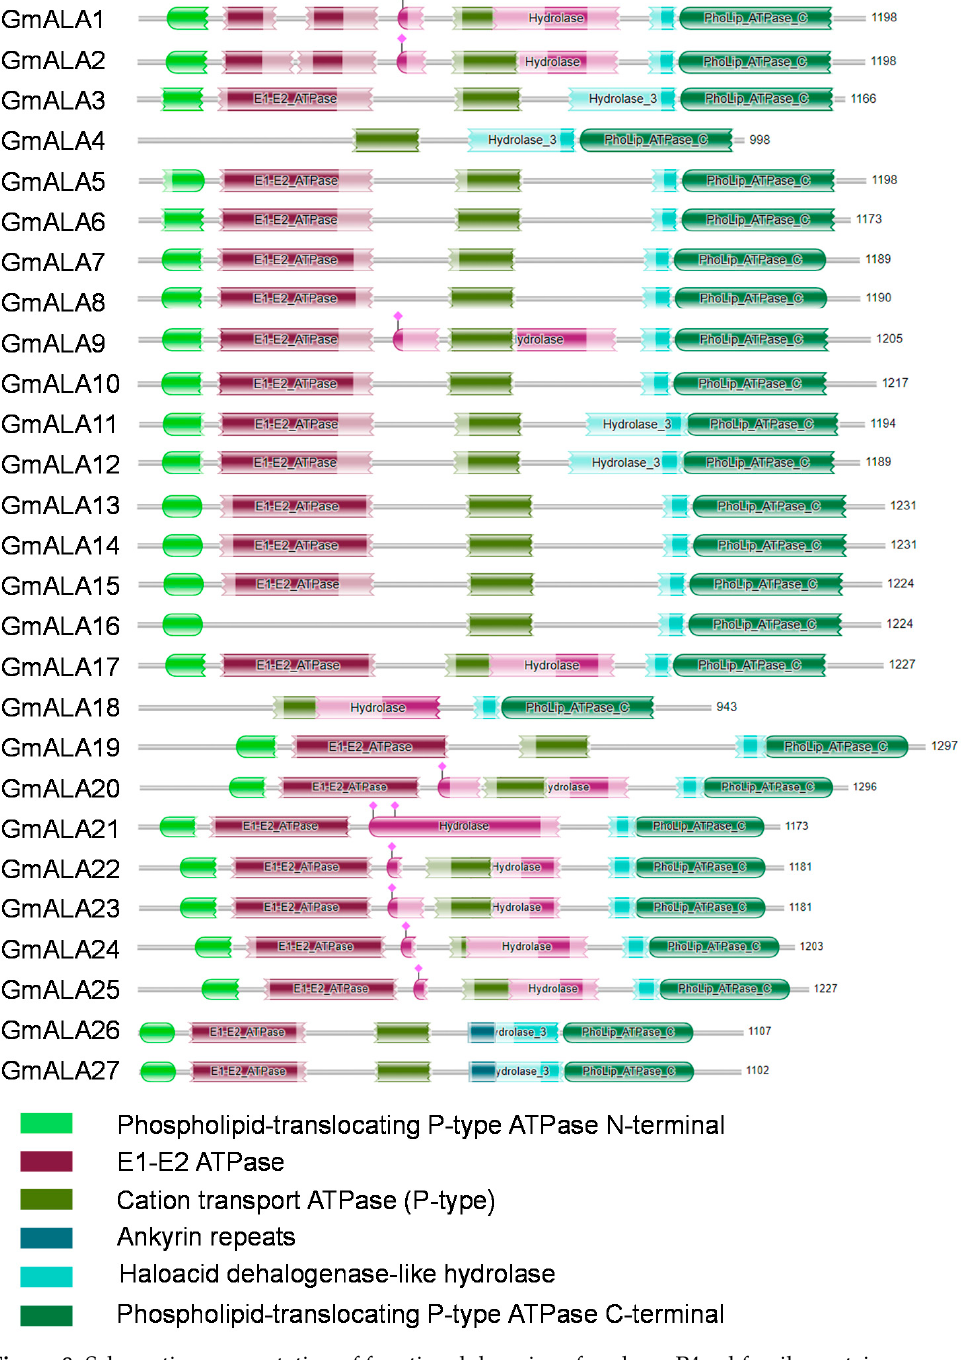
Figure 8. Schematic representation of functional domains of soybean P4 subfamily proteins.